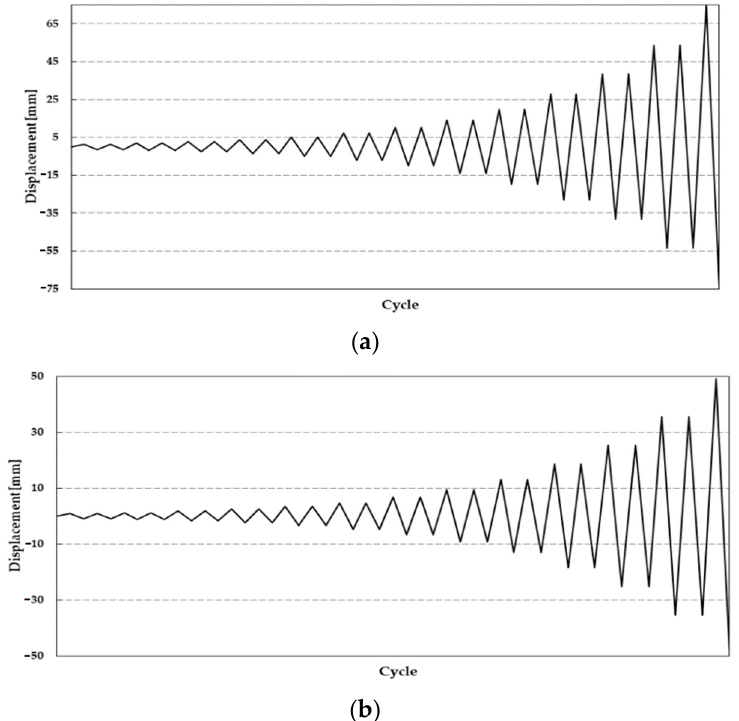
Figure 4. Cyclic loading pattern of ( a ) H-series and ( b )